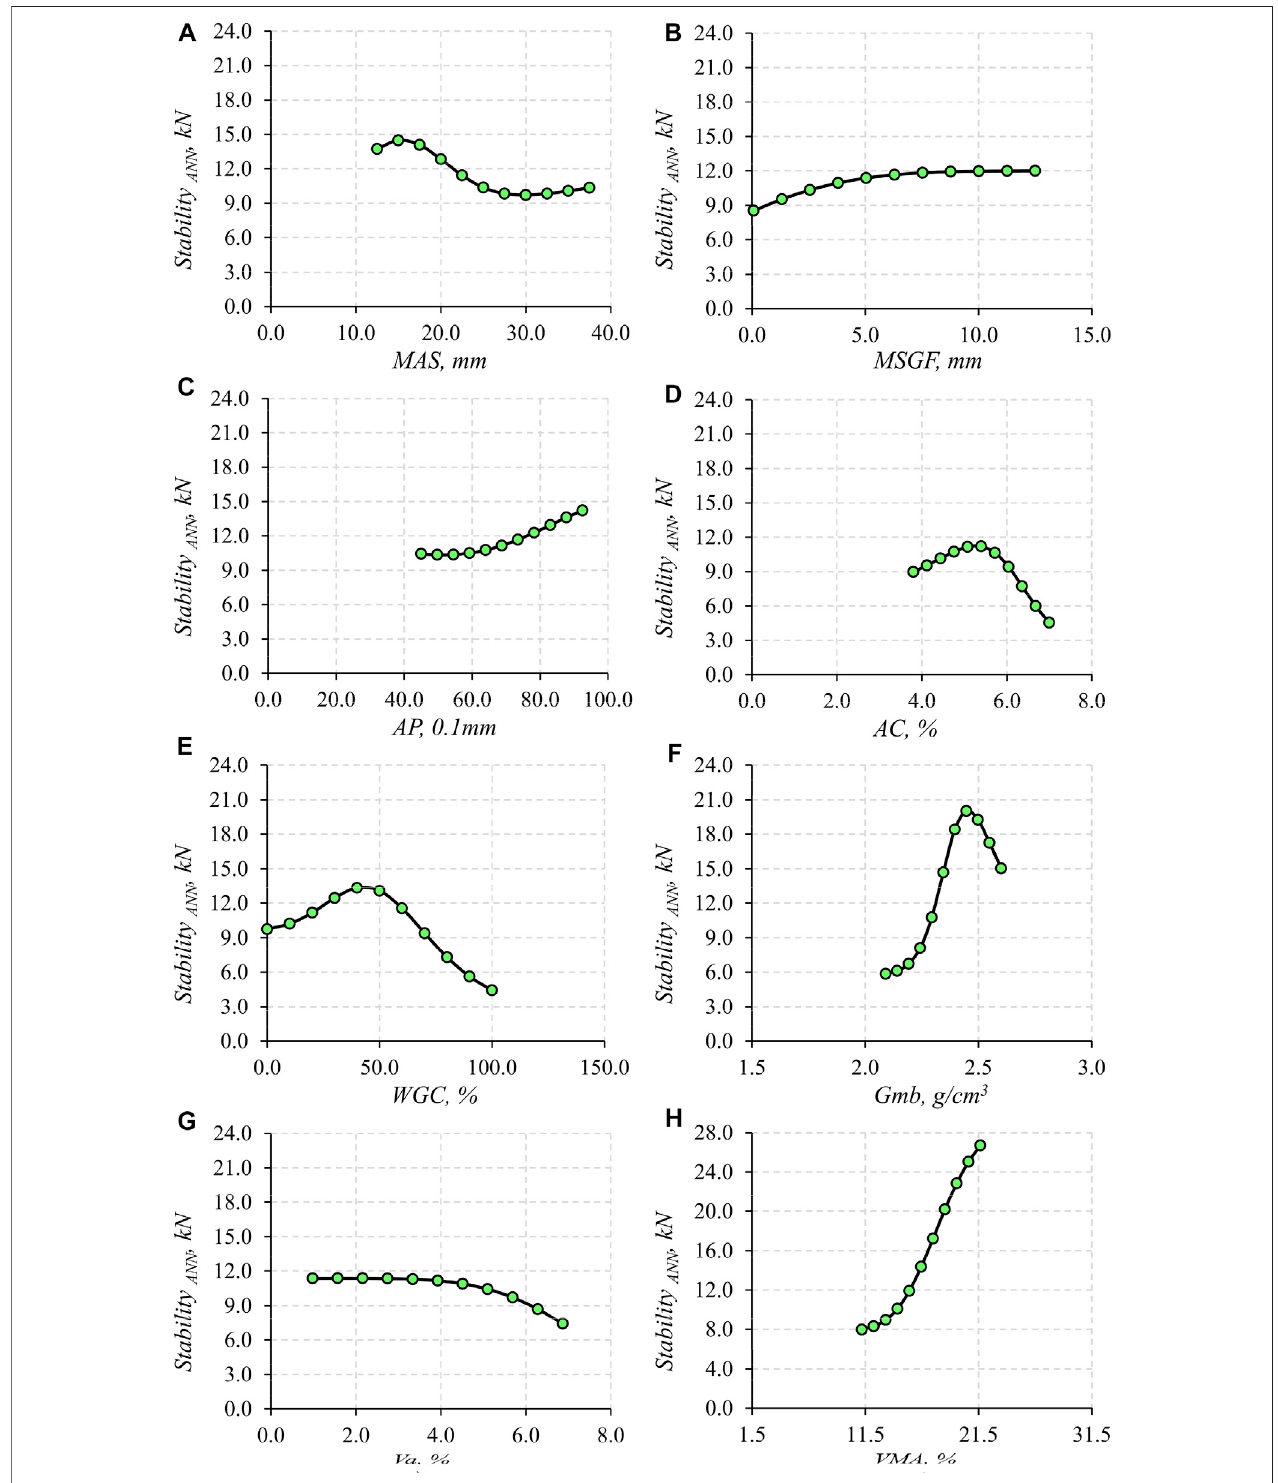
FIGURE 5 | Parametric study for glasphalt stability versus (A) Maximum aggregate size (MAS), (B) Maximum size of waste glass fractions (MSGF), (C) Average penetrationgradeofasphalt(AP), (D) Asphaltcontent(AC%), (E) Wasteglasscontent(WGC%), (F) Bulkspeci fi cgravityofglasphaltmixture, (G) Airvoidscontent(Va%), and (H) Voids in mineral aggregate (VMA%).